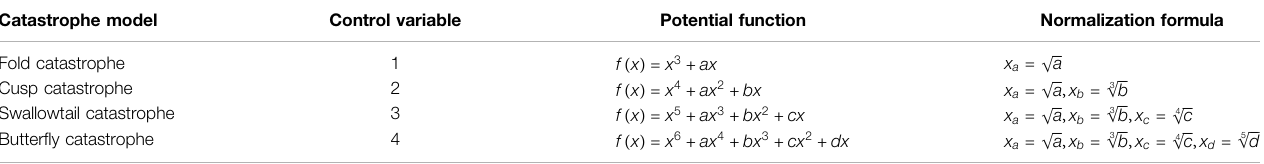
TABLE 1 | Common catastrophe models and their normalization